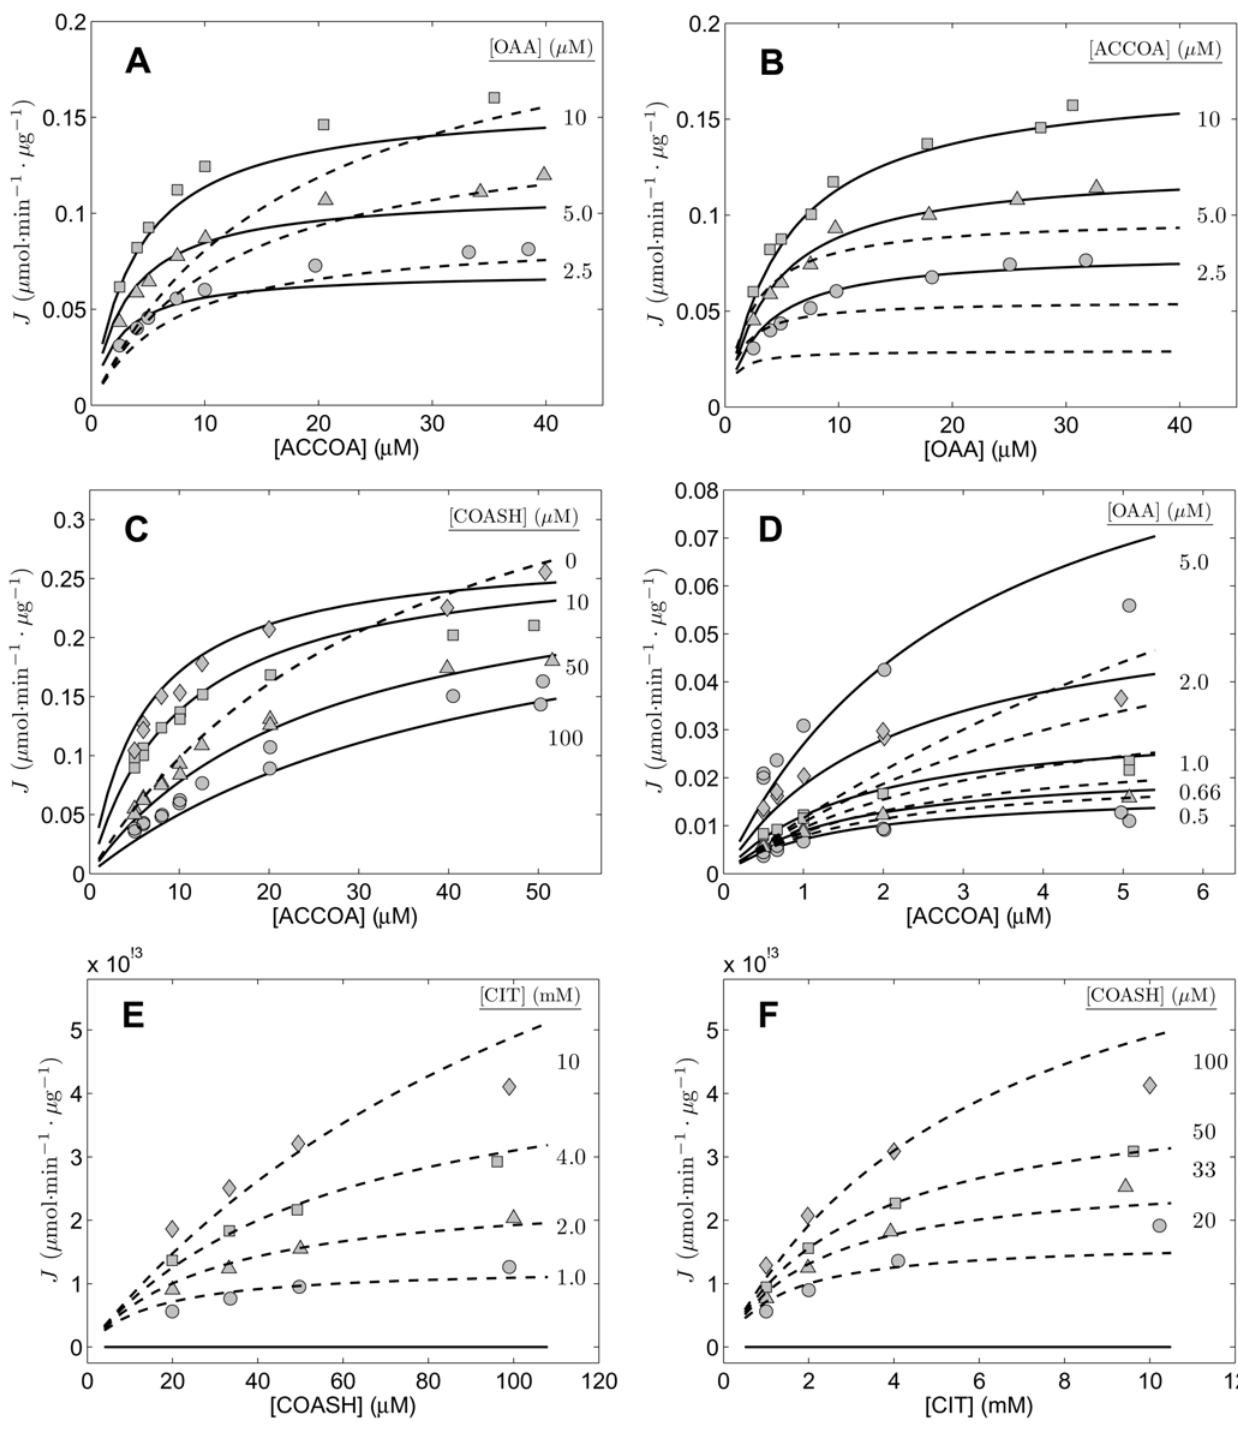
Figure 7. Analysis using random-order model of Equation (26). Data and conditions in A, B, C, and D are the same as for Figure 2. Data and conditions for E and F are the same as for Figures 3A and 3B, respectively Parameter values for solid line model predictions are V max =0.320 m mol ? min 2 1 ? m g 2 1 , K mB =6.20 m M, K mP =8.00 m M, K eA =1.35 m M, K eB =1.10 m M, K eP =21.6 nM, K eQ =0.150 m M. Parameter values for dashed line model predictions are V